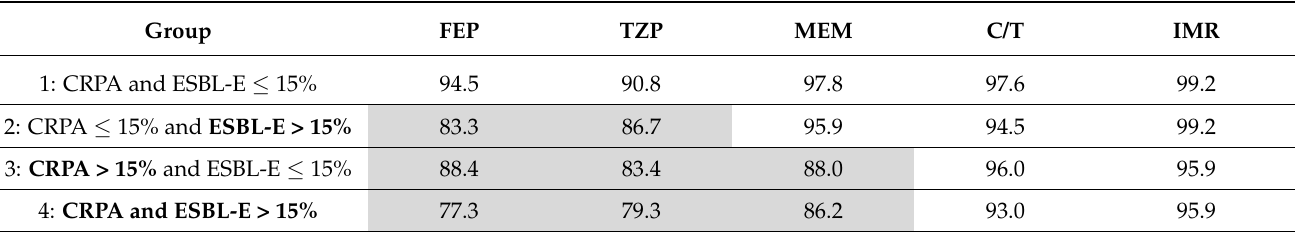
Table 1. Syndromic antibiogram evaluating resistant phenotypes, including CRPA and ESBL-E.